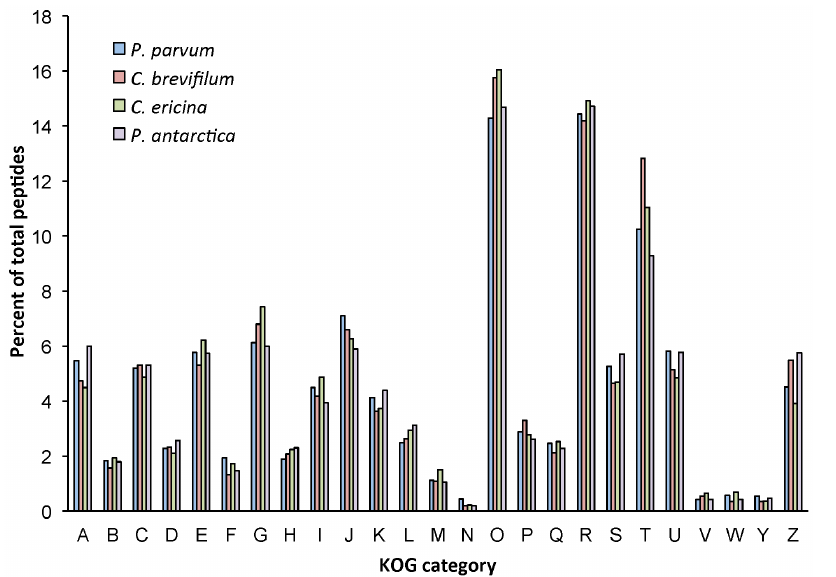
Figure 4. KOG function distribution of the peptides for the four target species in this study. The KOG functions are as follows: A: RNA processing and modification; B: chromatin structure and dynamics; C: Energy production and conversion; D: Cell cycle control, cell division, chromosome partitioning; E: Amino acid transport and metabolism; F: Nucleotide transport and metabolism; G: Carbohydrate transport and metabolism; H: Coenzyme transport and metabolism; I: Lipid transport and metabolism; J: Translation, ribosomal structure and biogenesis; K: Transcription; L: Replication, recombination and repair; M: Cell wall/membrane/envelope biogenesis; N: Cell motility; O: Posttranslational modification, protein turnover, chaperones; P: Inorganic ion transport and metabolism; Q: Secondary metabolites biosynthesis, transport and catabolism; R: General function prediction only; S: Function unknown; T: Signal transduction mechanisms; U: Intracellular trafficking, secretion and vesicular transport; V: Defense mechanisms; W: Extracellular structures; Y: Nuclear structure; Z: Cytoskeleton.